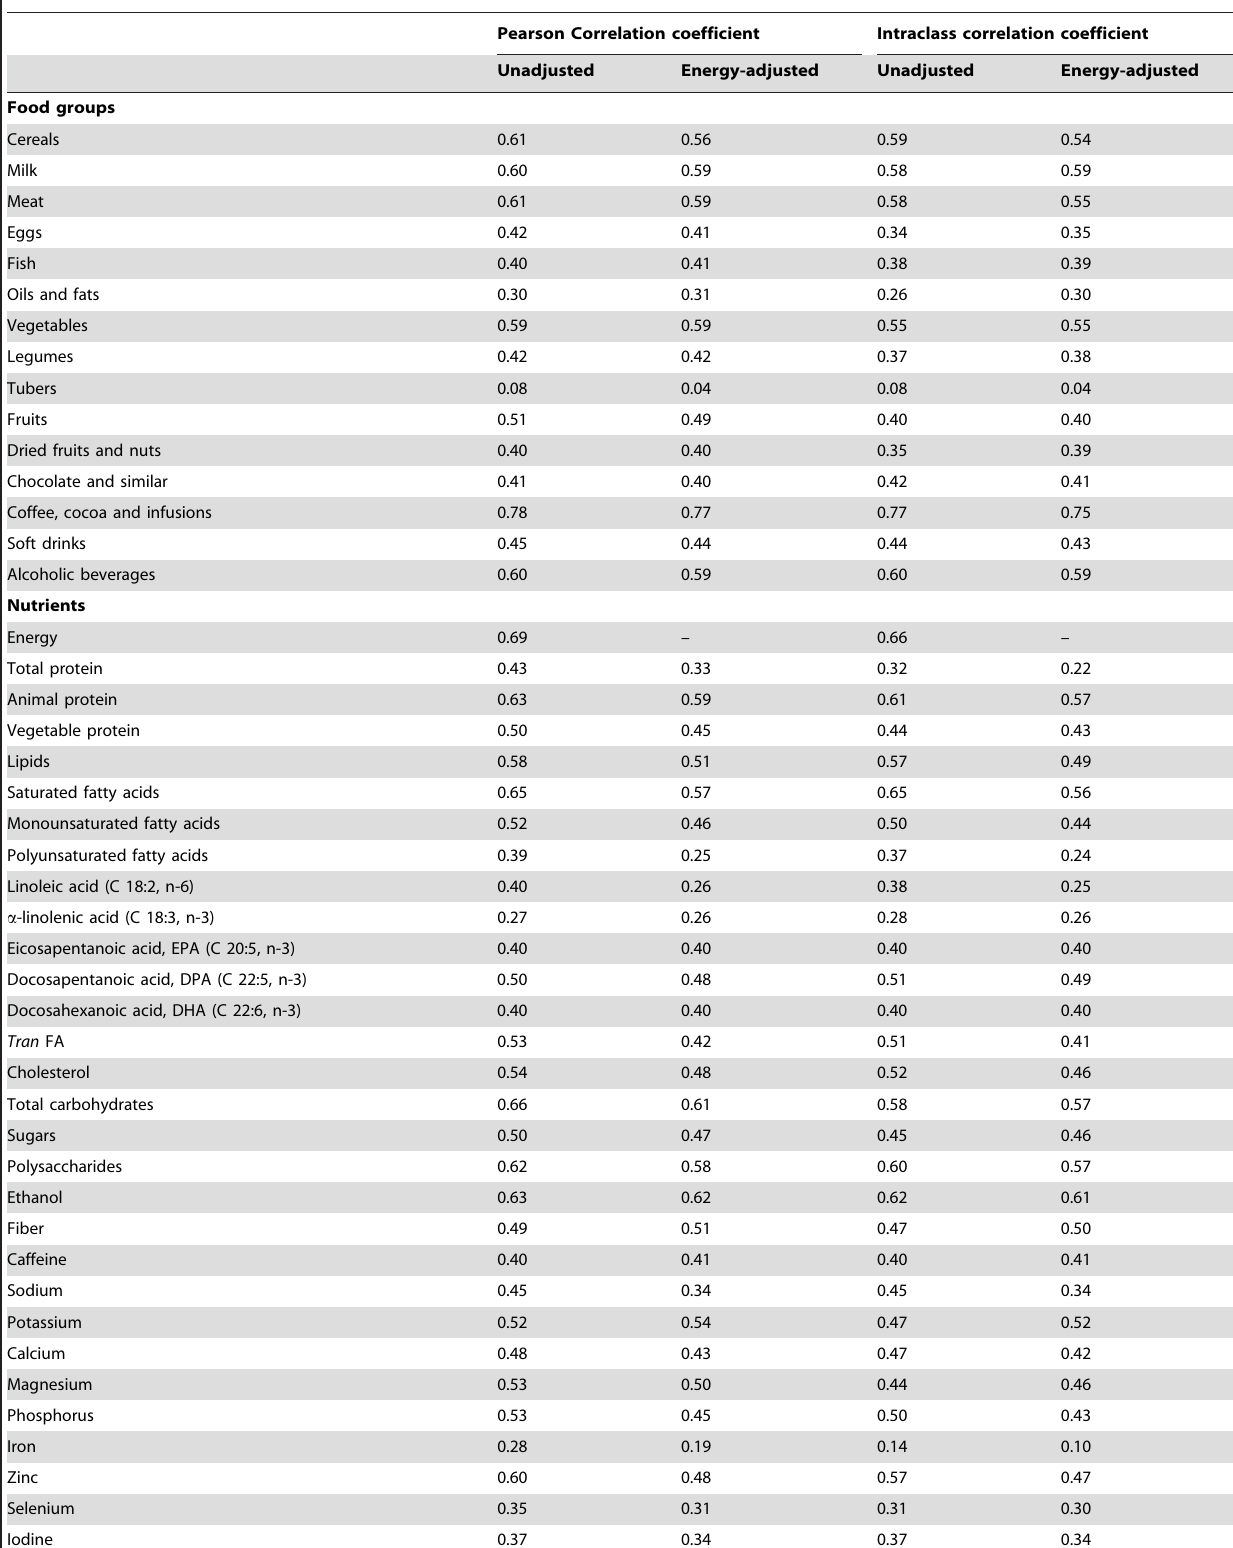
Table 6. Reproducibility of DH-E. Correlation coefficients between DH-E1 (at study baseline) and DH-E2 (at 12 months from